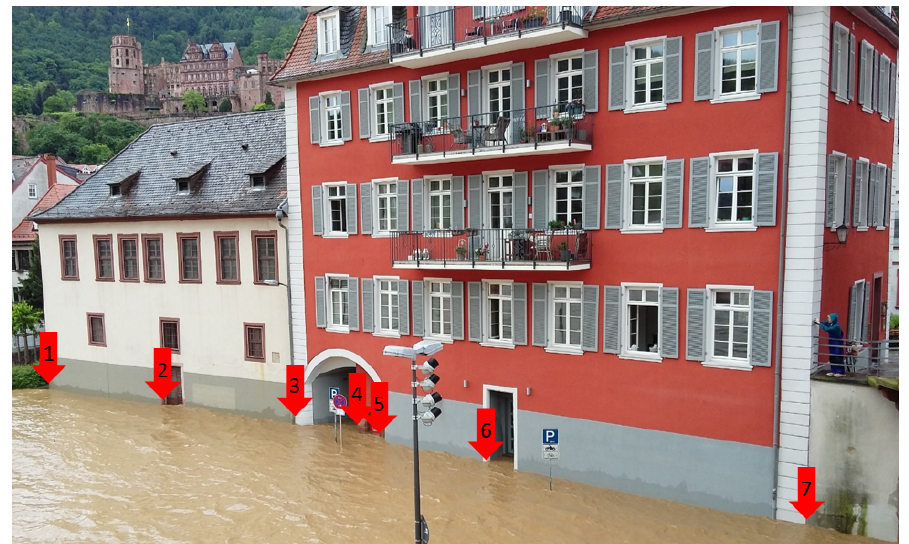
Figure 2. Example flood image with reference positions for manual in-field inundation depth measurements at the study site indicated with red